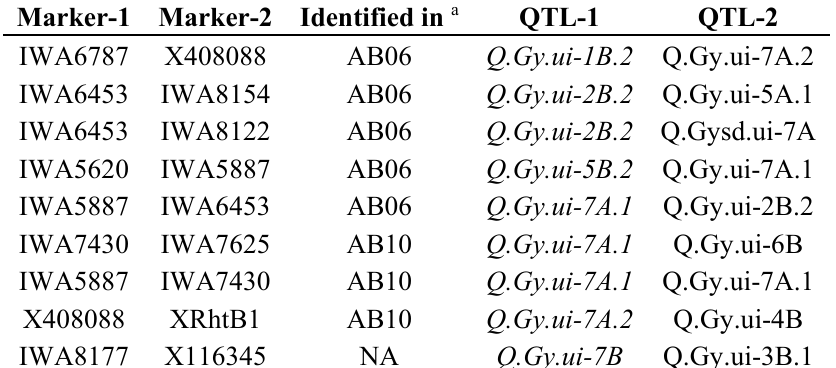
Table 7. QTL pairs that showed significant QTL × QTL × environment interactions.